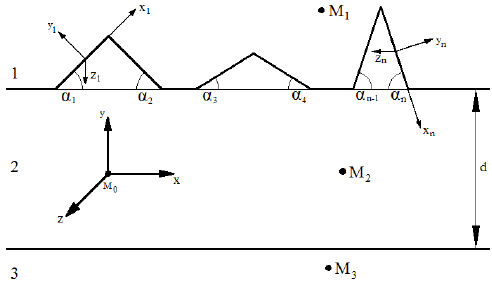
Fig. 1. Geometry of the problem under